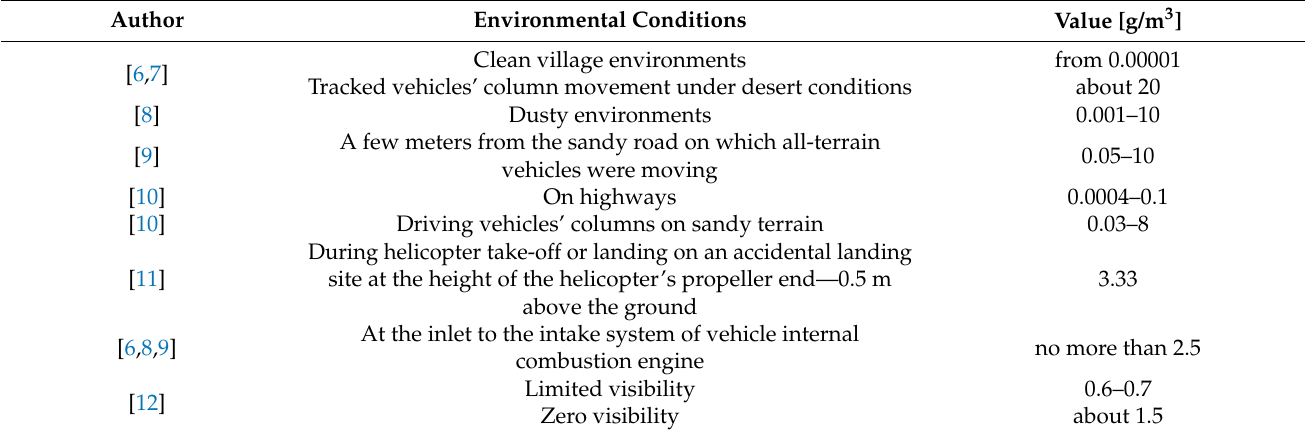
Table 1. Dust concentrations under various air